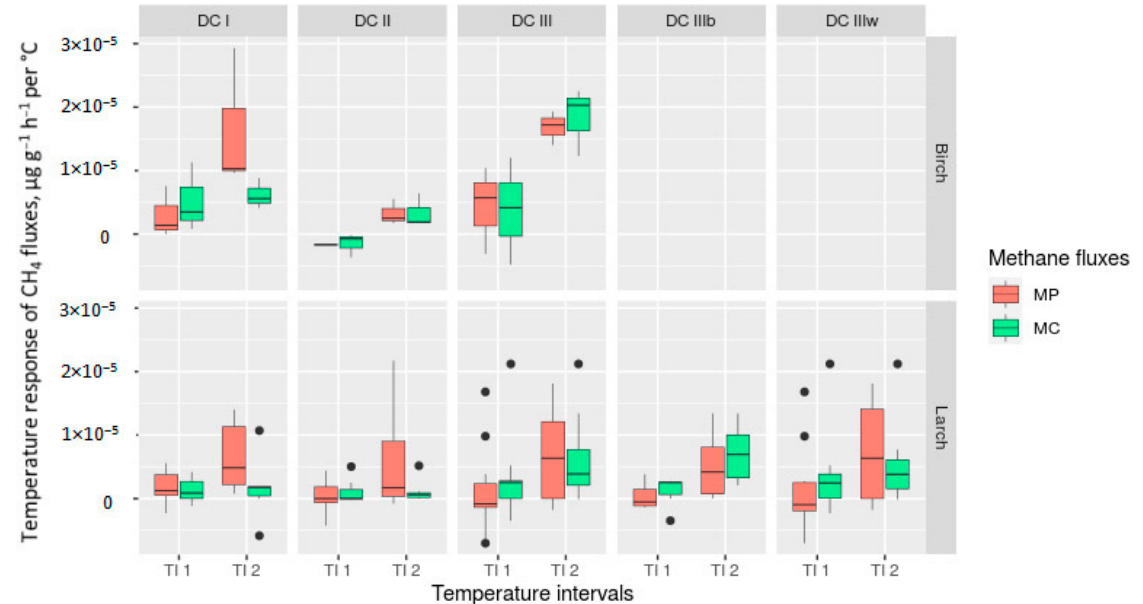
Figure 8. Temperature response of the CH 4 fluxes during decomposition of larch and birch CWD at different decomposition classes: MP—methane production; MC—methane consumption; TI 1—temperature interval from +5 to +15 °C; TI 2— temperature interval from +15 to +25 °C; DC I—DC III—decomposition classes; DC IIIb and DC IIIw—wood of Decomposition Class III decomposed by brown rot and white rot fungi, respectively.